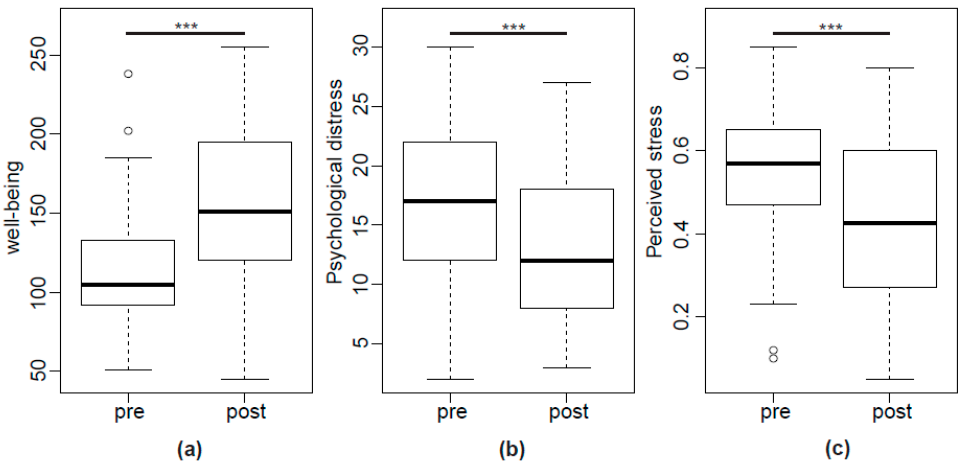
Figure 5. ( a ) well-being (VAS), ( b ) psychological distress (HADS), and ( c ) perceived stress before and after GHT, *** p < 0.001.